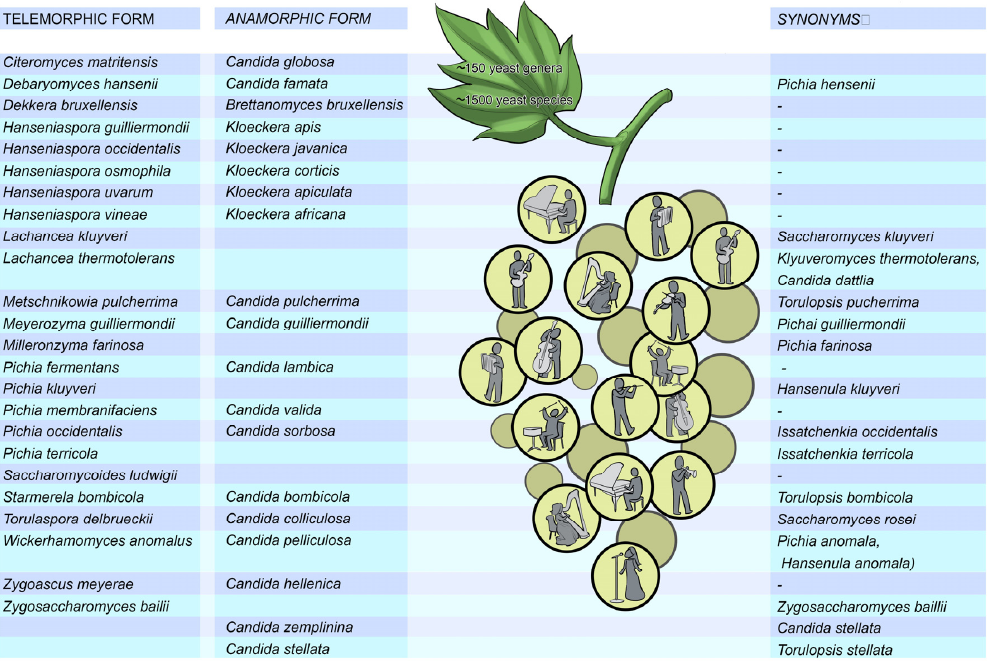
Figure 8. Teleomorphs, anamorphs and synonyms of some of the non ‐ Saccharomyces yeasts in the Ascomycetous genera reported to have been found on grapes and in wine fermentations (adapted from [13]).